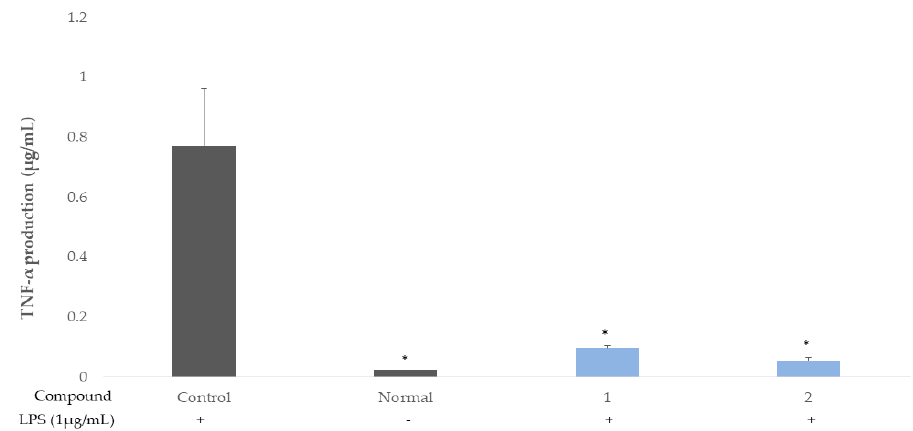
Figure 5. Inhibitory activities of 1 and 2 on TNF- α production in the THP-1 macrophage cell. Control, compounds 1 and 2 were added LPS (1 µ g/mL). Normal was not added LPS. Values are expressed as means ± standard deviations (SDs) from triplicate measurements. * p < 0.05 .